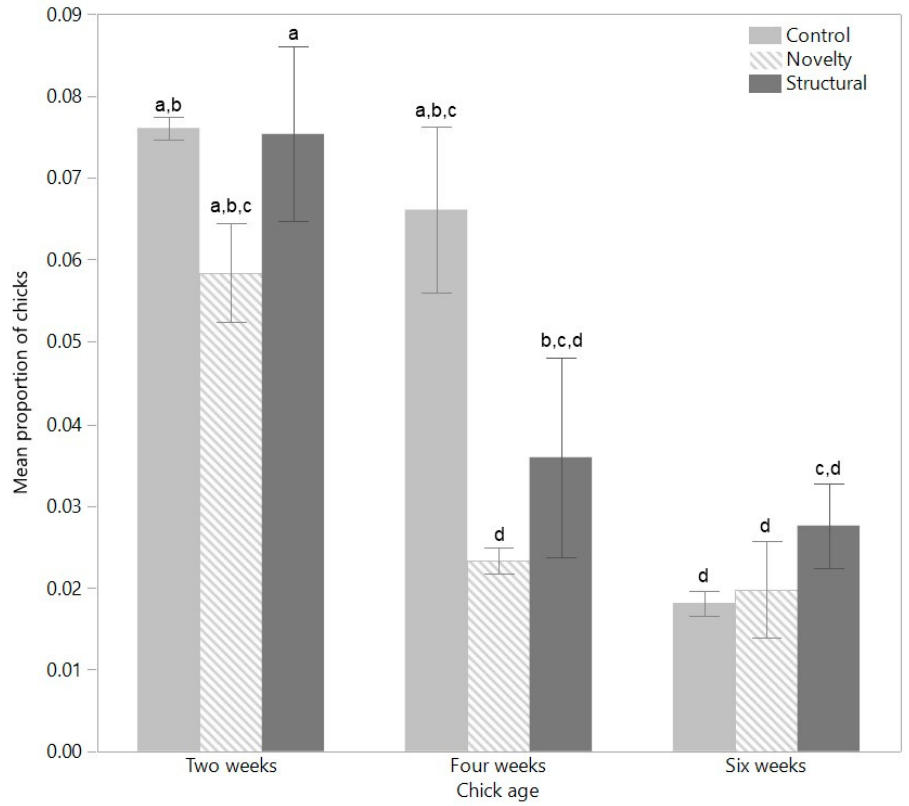
Figure 2. The mean ( ± SEM) proportion of chicks from three rearing treatments (control, novelty, structural) running within the pens across three age points (2, 4, 6 weeks). a–d Dissimilar superscript letters indicate significant differences across rearing treatments and age. Raw data are presented with analyses conducted on transformed means.